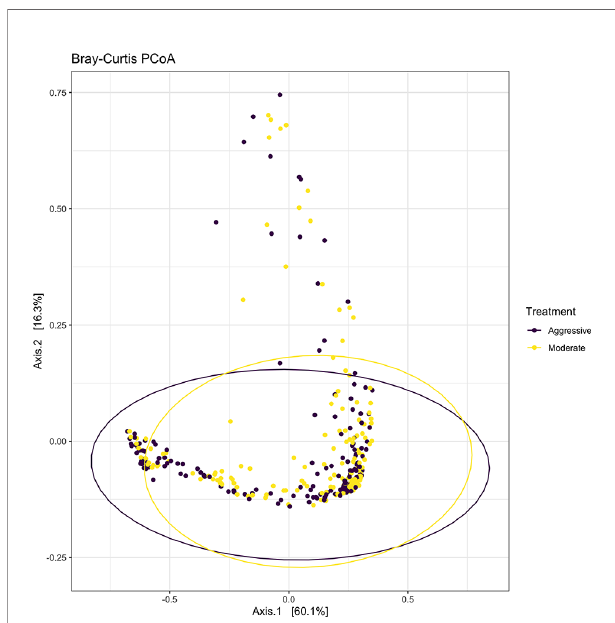
FIGURE 6 | Beta-diversity measurements for archaeal communities using Bray-Curtis distances to create a PCoA. Aggressive treatments are represented in purple and moderate treatments are represented in yellow. Ellipses represent 95% con fi dence intervals around means for aggressive and moderate implant strategies. Signi fi cant overlap between communities reveals no differences between moderate or aggressive treatments.